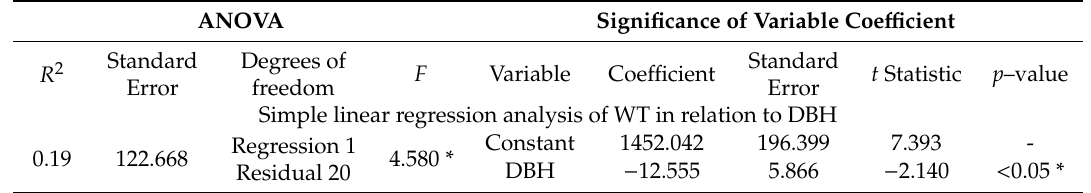
Table 8. Analysis of the simple correlation coe ffi cient and of the significance of test F. ANOVA Independent Variable r F p -Value V 0.34 2.620 > 0.05 SD 0.34 2.541 > 0.05 H 0.08 0.138 > 0.05 LC 0.06 0.074 > 0.05 D 0.02 0.012 >